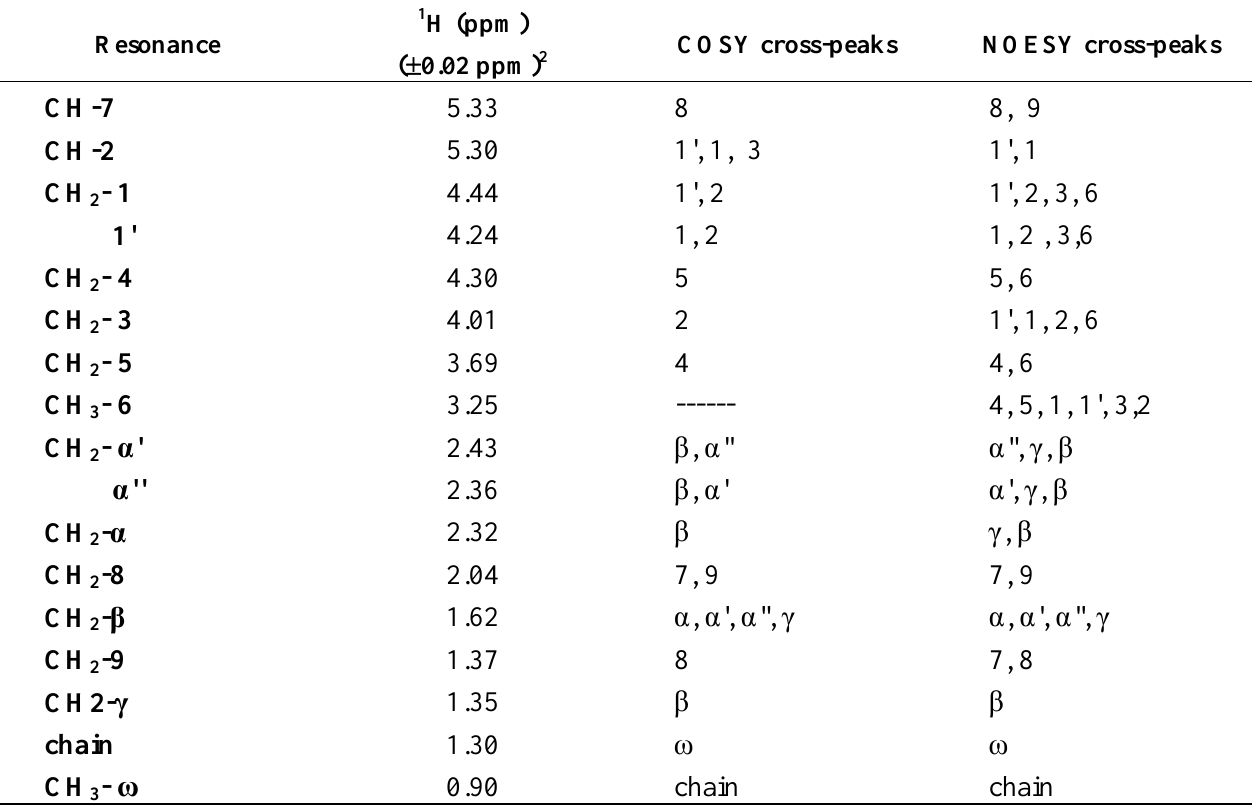
Table 2. Assignment of 1 H HR-MAS spectrum of POPC MLVs (50 mg/mL) 1 .